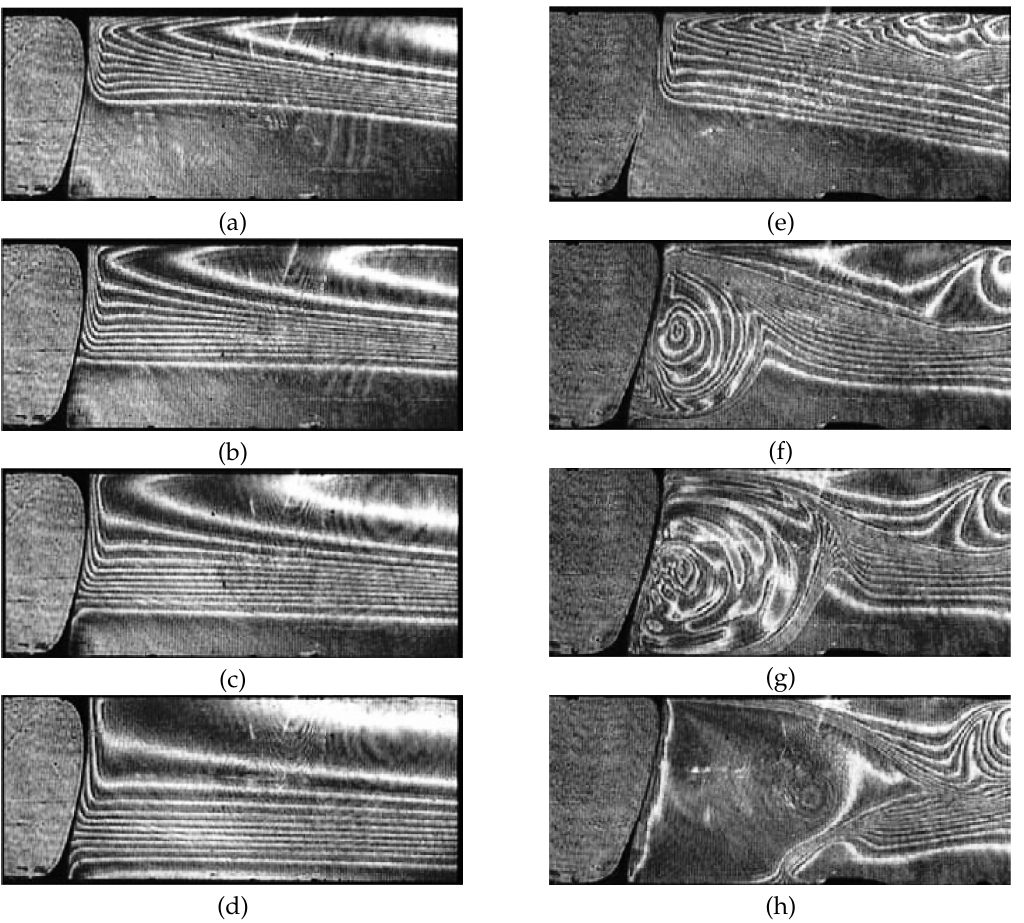
Figure 3. Evolution of the concentration field near the air bubble in the absence of pronounced convective mass transfer ( a – d ) for C 0 = 5 wt.% and at the onset of relaxation oscillations due to the coupling of solutal Marangoni convection with buoyancy and diffusion ( e – h ) for C 0 = 6 wt.%. The left and right frames from up to down correspond to time t : 0 s ( a ); 13 s ( b ); 30 s ( c ); 105 s ( d ); 0 s ( e ); 15.3 s ( f ); 17 s ( g ); and 22 s ( h